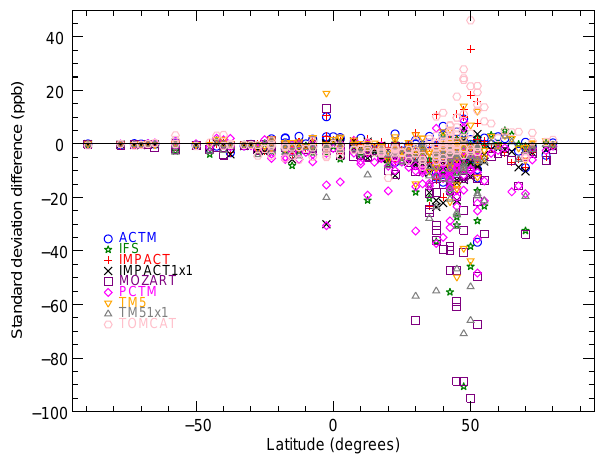
Fig. 5. Latitudinal distribution of the “synoptic” standard devia- tion (STD) differences between LMDZ-SACS and other TransCom models at all surface stations ( σ LMDZ-SACS − σ ( TransCom model ) Each TransCom model is represented by a specific symbol. The STD difference is expressed in